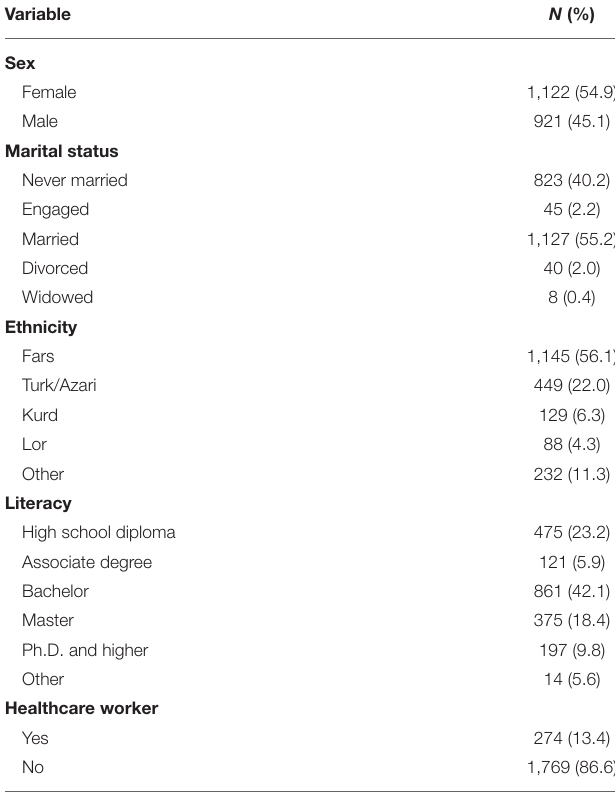
TABLE 1 | Socio-demographic characteristics of